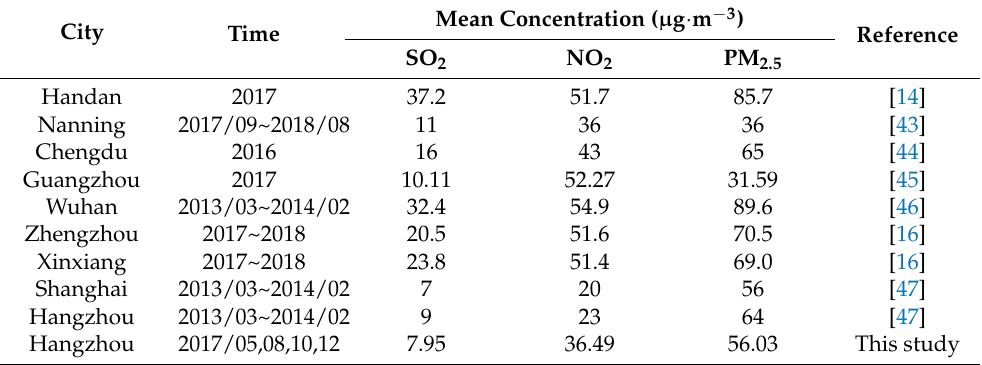
Table 1. The mean concentrations of SO 2 , NO 2 and PM 2.5 in Hangzhou and other